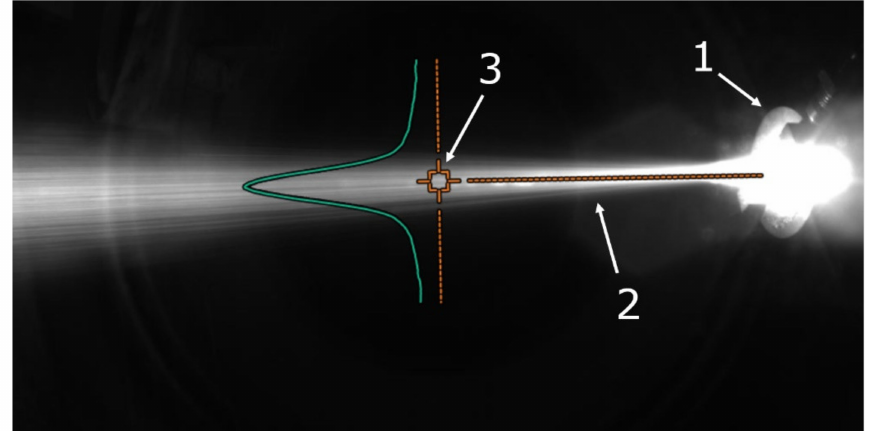
Figure 11. Camera view of Accuraspray 4.0 system. 1—plasma torch, 2—plasma plume, and 3—area of temperature and velocity